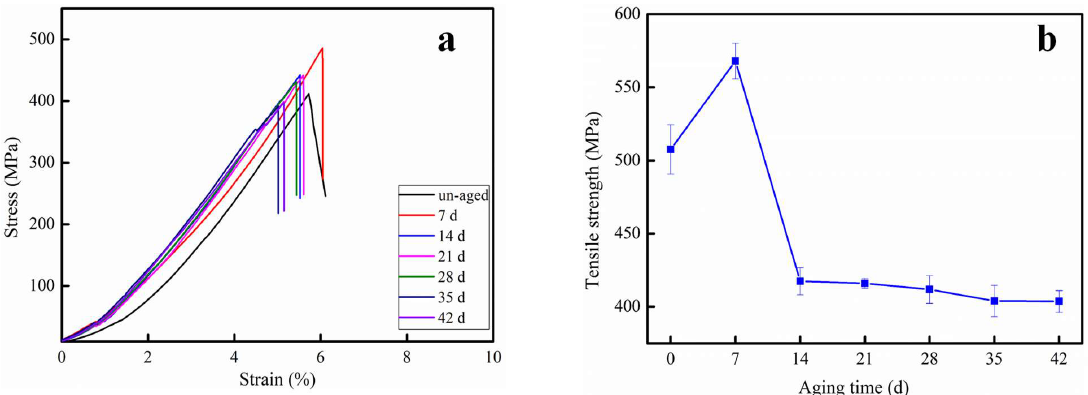
Figure 4. Tensile properties for CF / PC composites. ( a ) the representative stress strain curves of CF / PC composites with di ff erent hydrothermal aged, ( b ) tensile strength of CF / PC composites with di ff erent hydrothermal aged. 1 mm / min.